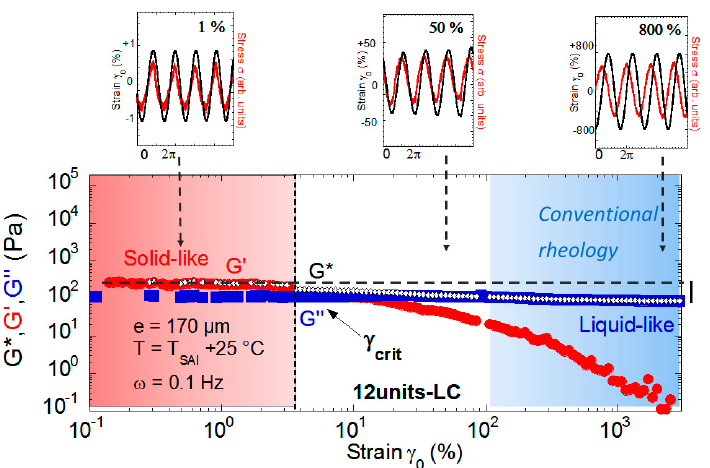
Figure 11. Strain dependence (logarithmic scales) of the viscoelastic moduli (G’ (•), G” ( ■ )) of the 12-unit LC in the isotropic phase (T = TS AI + 25 °C) at a 0.170-mm gap thickness and ω = 0.1 Hz (from reference [22]). The solid-like response at small strain amplitudes is progressively replaced by a liquid-like behavior with increasing strains. This behavior is highlighted by the strain (black line) and stress (red line) waves that are in phase in the elastic regime and π /2 phase shifted in the viscous regime (top figure). The grey dotted line indicates the reference value of the stress modulus in nearly equilibrium conditions.